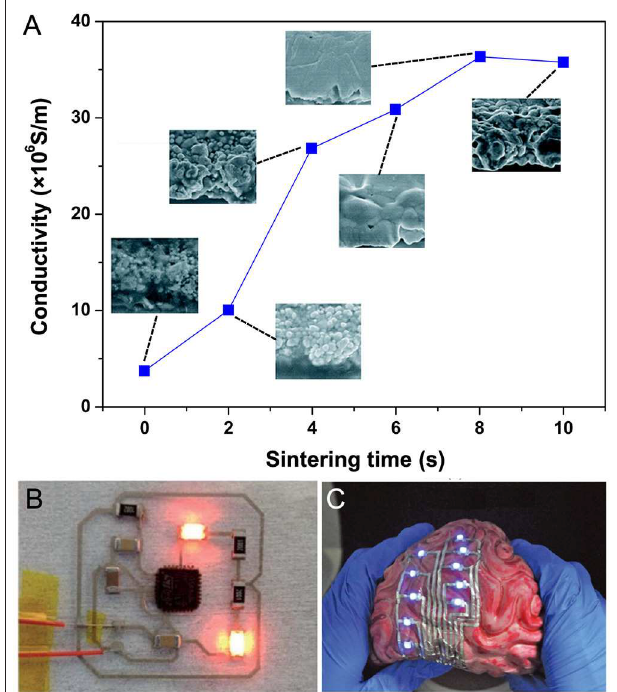
FIGURE 2 | The conductivity of AgNP film sintered by NIR with a power of 360 kW/m 2 and SEM images of the sintered film at 0, 2, 4, 6, 8, and 10s, respectively (A) , and a flexible hybrid circuit integrated electrical components and circuit screen printed with AgNP ink on a PET substrate (B) , and a flexible LED circuit printed with AgNP-Ga-In ink on a soft brain-shaped toy (C) . Reproduced with permissions from Gu et al. (2018). Copyright 2018, Royal Society of Chemistry. Reproduced with permissions from Tavakoli et al. (2018). Copyright 2018, Wiley-VCH.